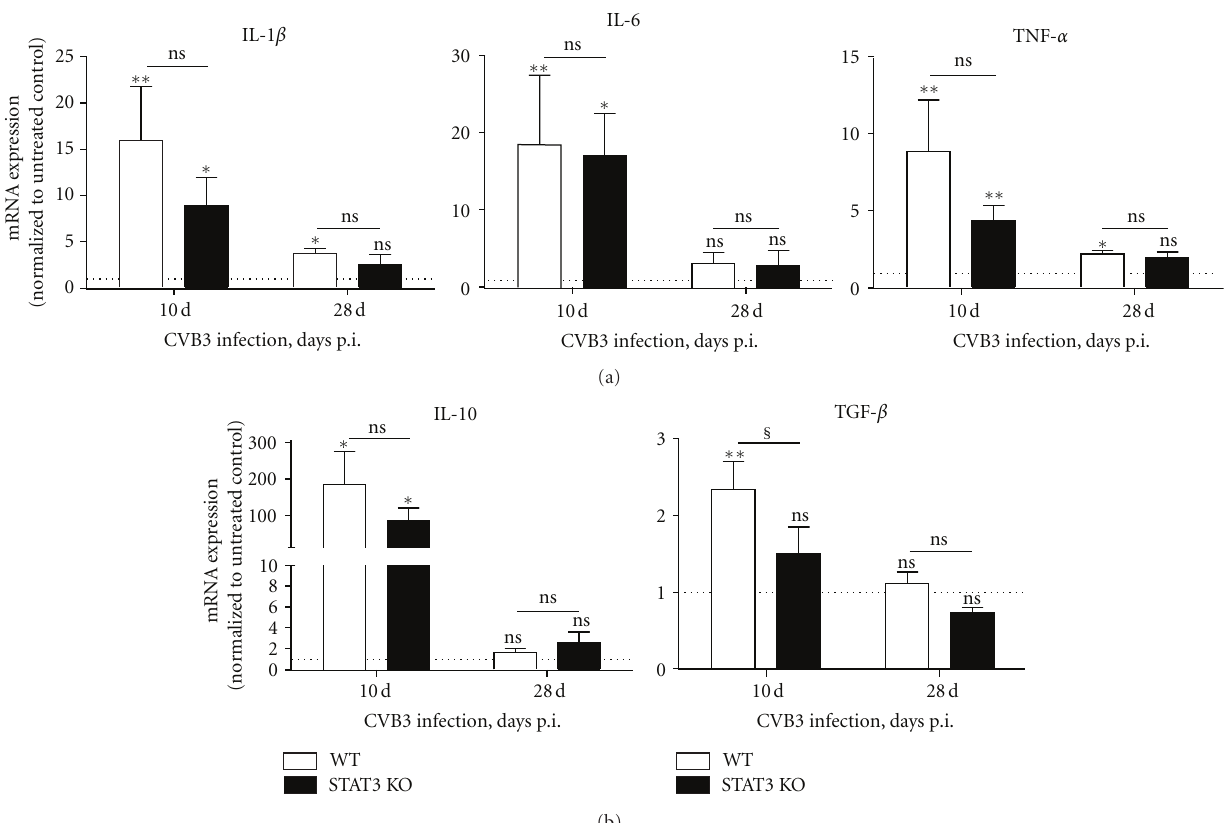
Figure 1: Cytokine expression levels in cardiac tissue of CVB3 infected mice. The mRNA expression levels are shown 10 and 28 days after CVB3 infection of WT and STAT3 KO mice. The expression data are normalized to the house-keeping gene 18S and to the expression levels of the corresponding untreated mice and expressed as x-fold over basal expression using the formula 2 − ΔΔ Ct . ∗ Data were compared to the expression of the corresponding untreated controls. ∗ P < 0 . 05; ∗∗ P < 0 . 01. § Data between WT and STAT3 KO mice were compared. § P < 0 . 05.